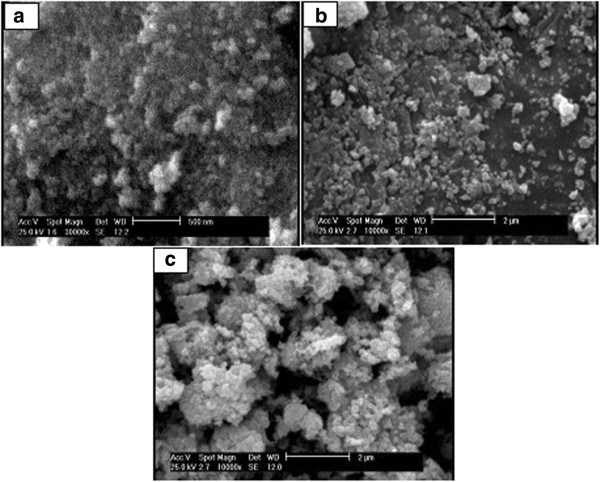
SEM images of (a): Fe3O4 (b): modified Fe3O4 (c) Fe3O4/ZnO core/shell.